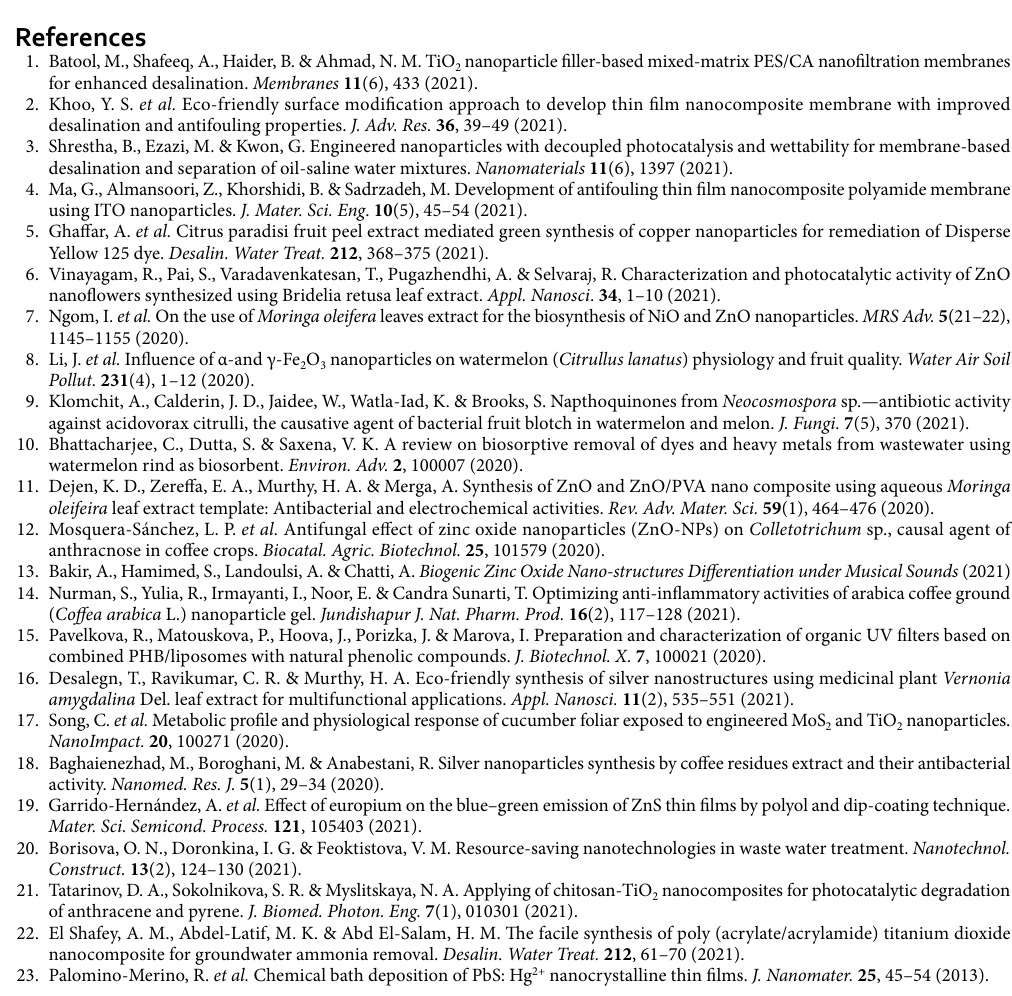
Data availability The data are included with in the article.